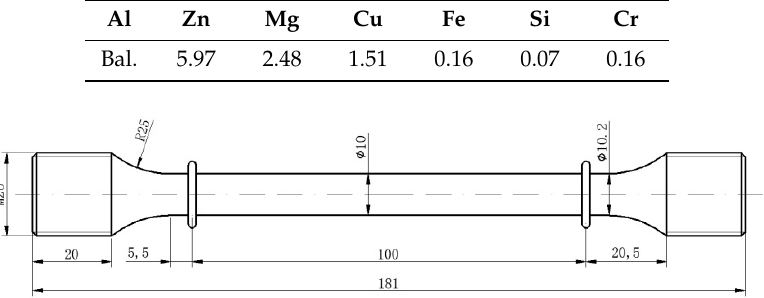
Figure 1. Geometry and size of samples (unit: mm).